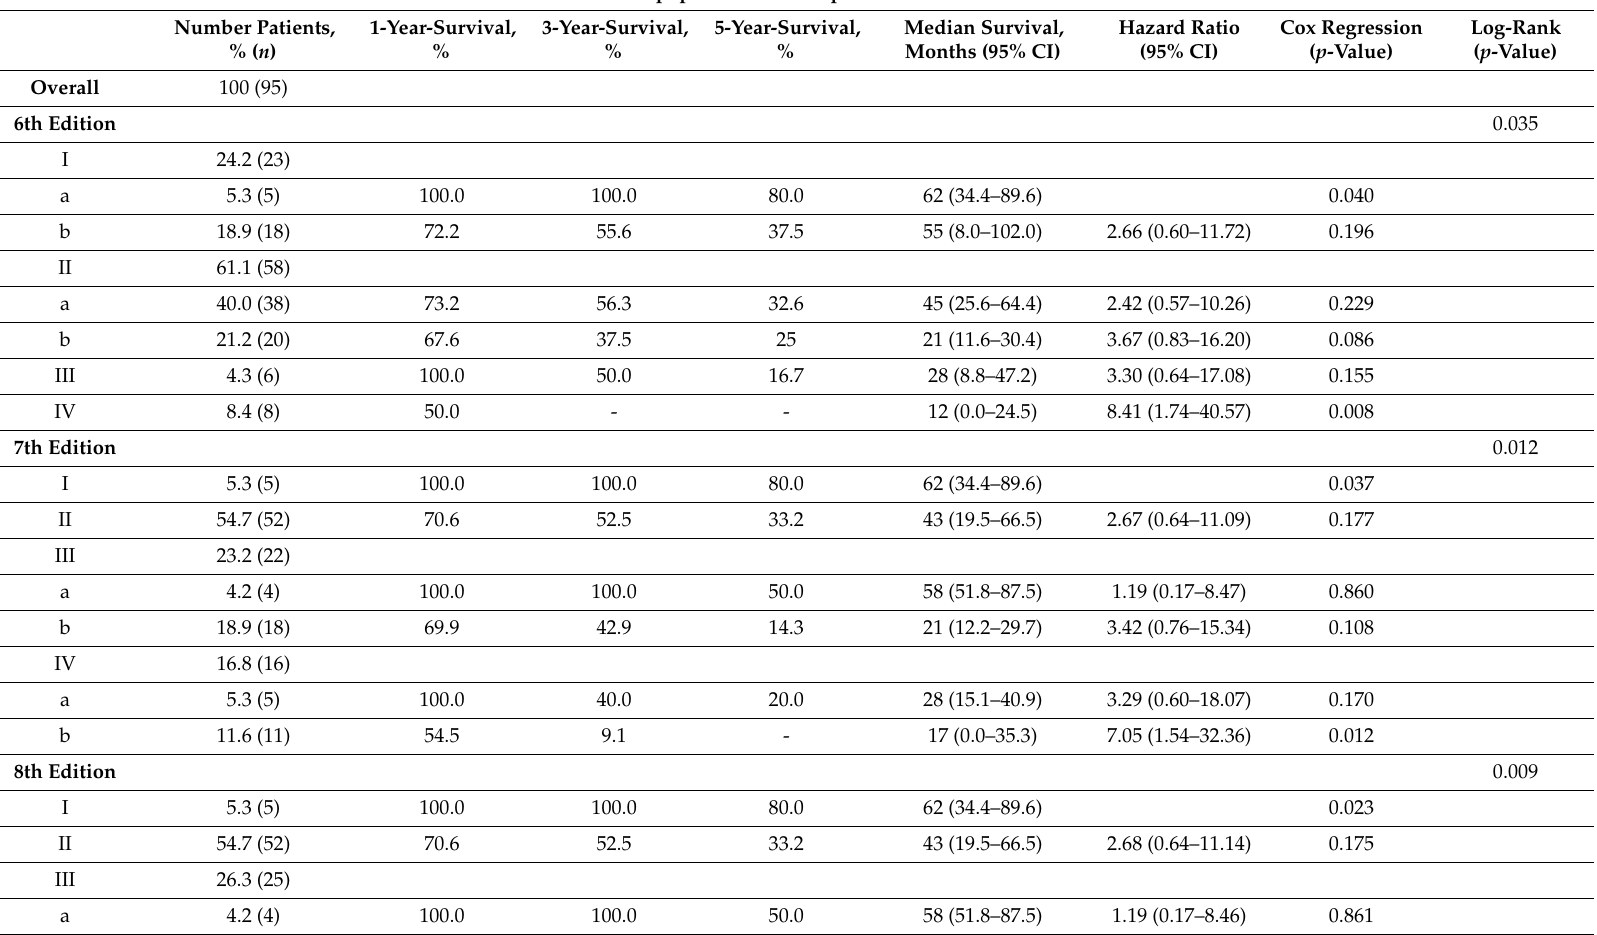
Table 6. Stage-specific survival rates due to the di ff erent TNM editions of the AJCC staging system. Subgroup stage-specific patient survival according to the 6th, 7th, and 8th editions of the American Joint Committee on Cancer (AJCC) staging system of our study population ( n = 95